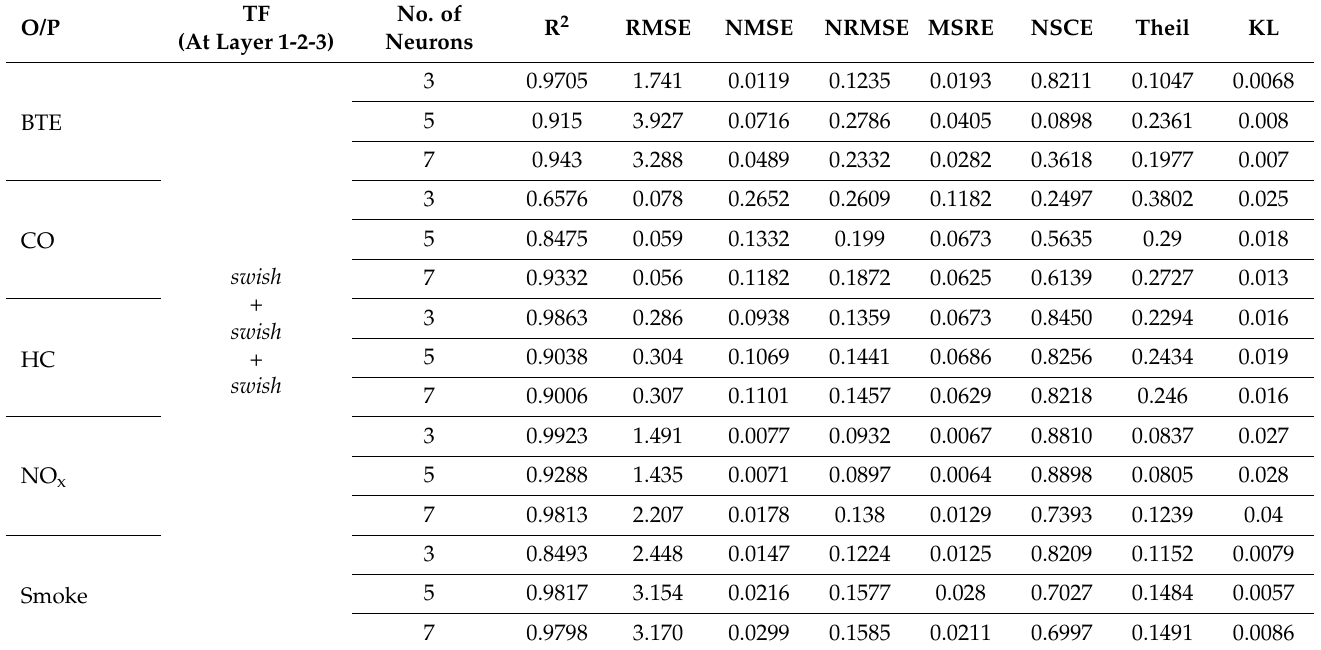
Table 6. Computation of R 2 , RMSE, NMSE, NRMSE, MSRE, NSCE, Theil, KL using 3, 5, and 7 neurons at hidden layer with swish activation function while computing BTE, CO, HC, NO x , and